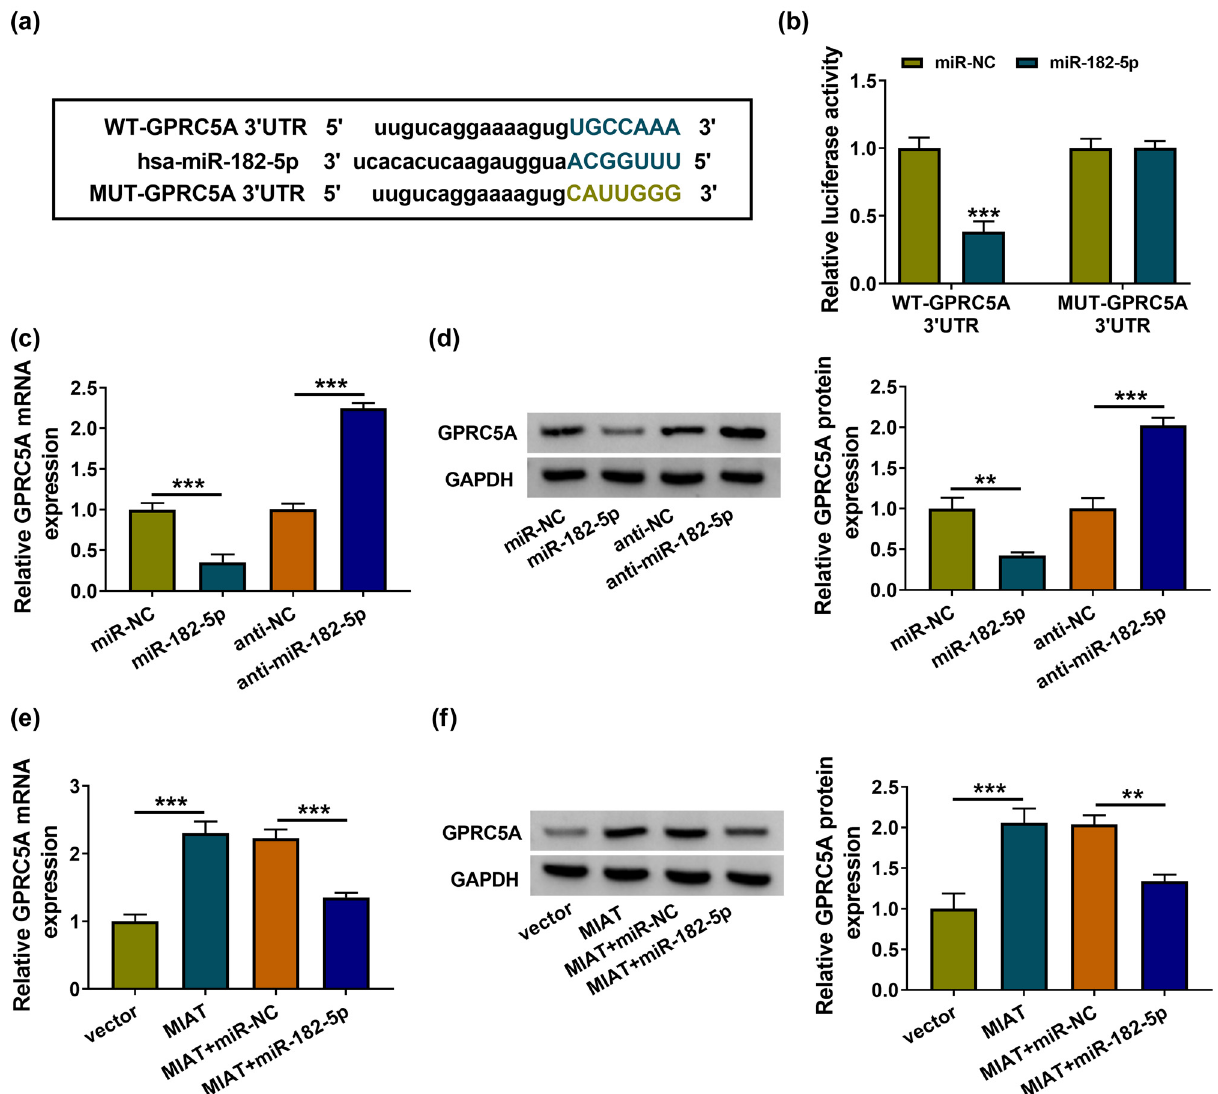
Figure 5: MIAT acted as an miR - 182 - 5p sponge to promote GPRC5A expression. ( a ) TargetScan was used for the bioinformatics analysis between miR - 182 - 5p and GPRC5A 3 ′ - UTR. ( b ) The binding of miR - 182 - 5p with GPRC5A 3 ′ - UTR was validated via the dual - luciferase reporter assay. ( c and d ) The RT - qPCR and western blot were administrated to assay the mRNA ( c ) and protein ( d ) expression of GPRC5A after transfection of miR - 182 - 5p, anti - miR - 182 - 5p, or the matched control groups. ( e and f ) GPRC5A detection was executed by RT - qPCR and western blot in vector, MIAT, MIAT + miR - NC, or MIAT + miR - 182 - 5p transfection group. ** P < 0.01, *** P <